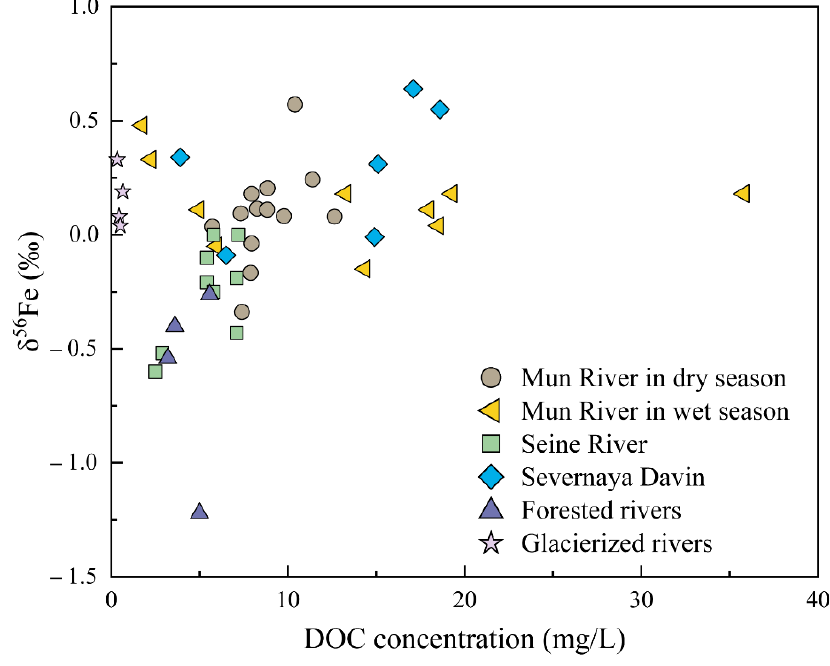
Figure 8. The relationship between Fe isotopes and DOC concentration in different climate zones. These data are from